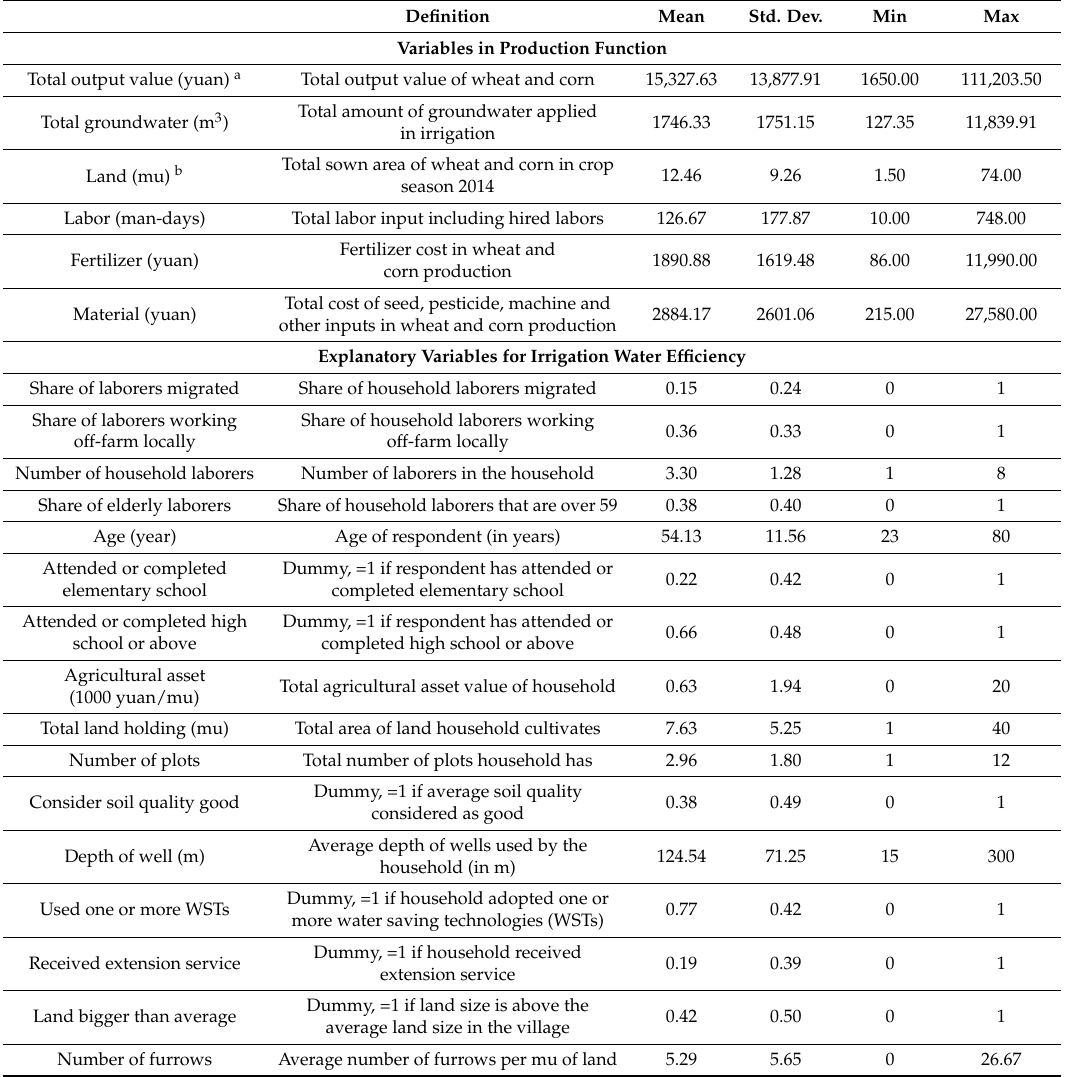
Table 1. Definition and summary of